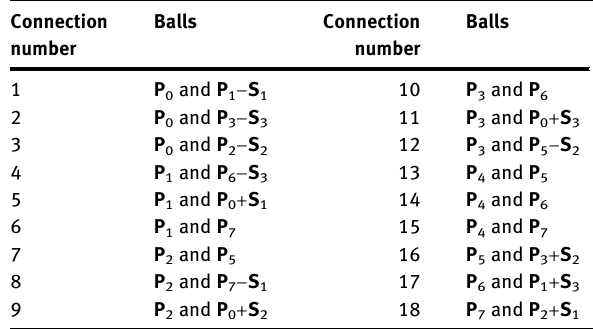
Table  : Connectivity between balls of single gyroid in Figure 